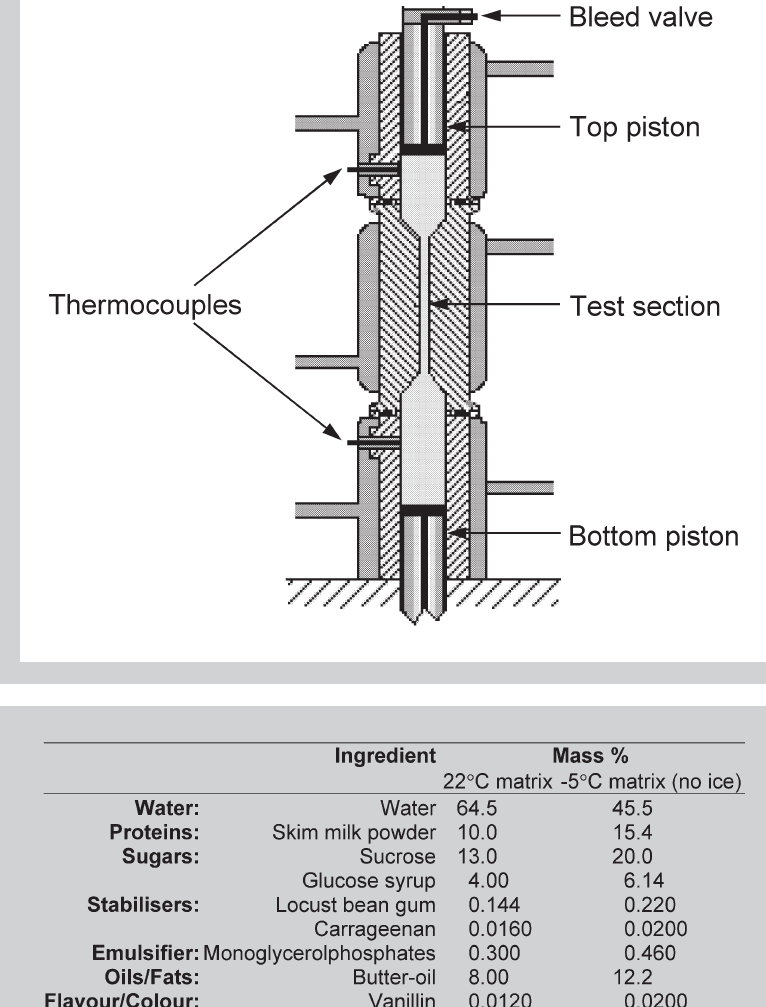
Figure 1: Schematic of the Multi-Pass Rheometer (MPR) III. Table 1: Matrix